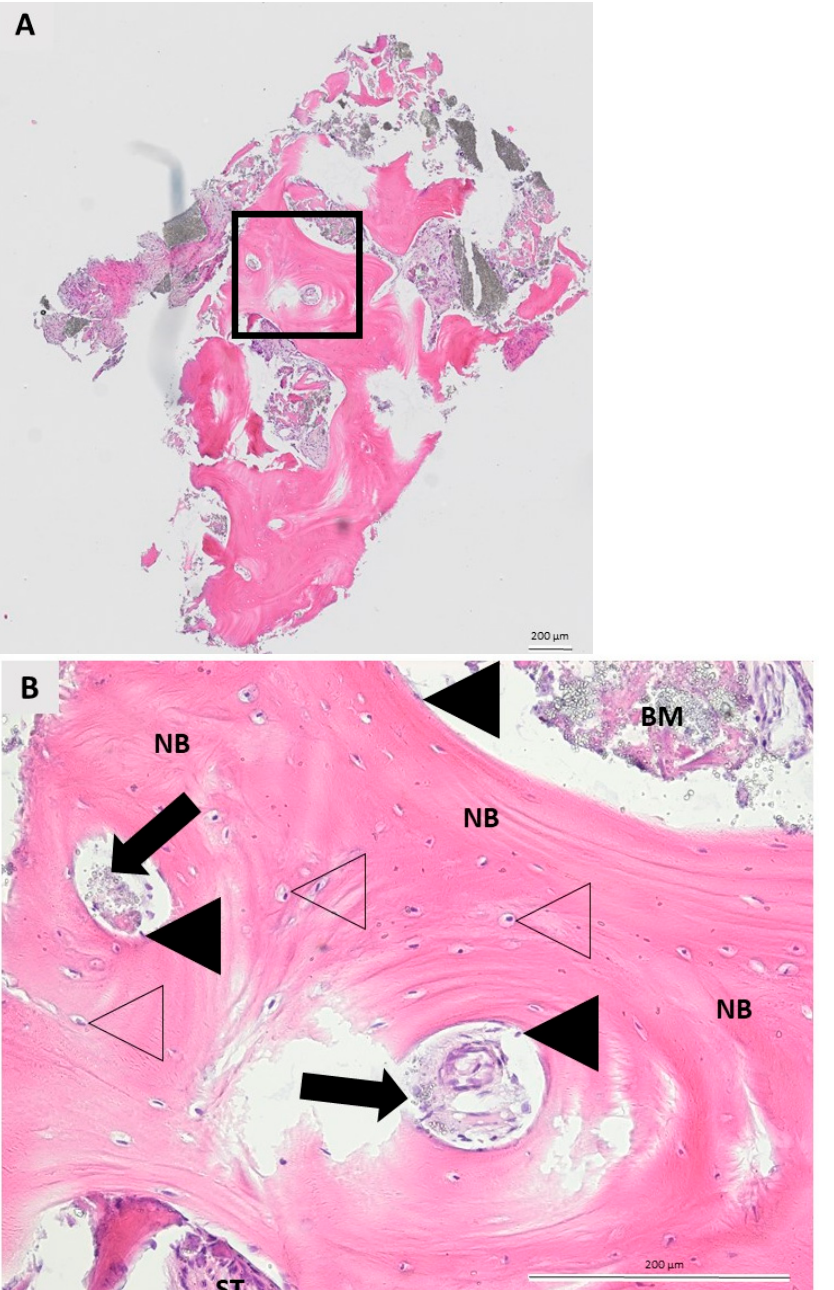
BM) is in direct contact with newly formed bone (NB) and soft tissue (ST). Formation of NB begins at the boundary between the IBCP and the defect. The cells in the calcified bone matrix are osteo- cytes (no filling triangles), whereas osteoblasts (black filling triangles), their precursor, were de- tected at the boundary between IBCP and NB. Note the remaining IBCP granules (black filling tri- angles) integrated into the NB. No inflammatory tissue reaction was observed (hematoxylin-eosin, 20x magnification).